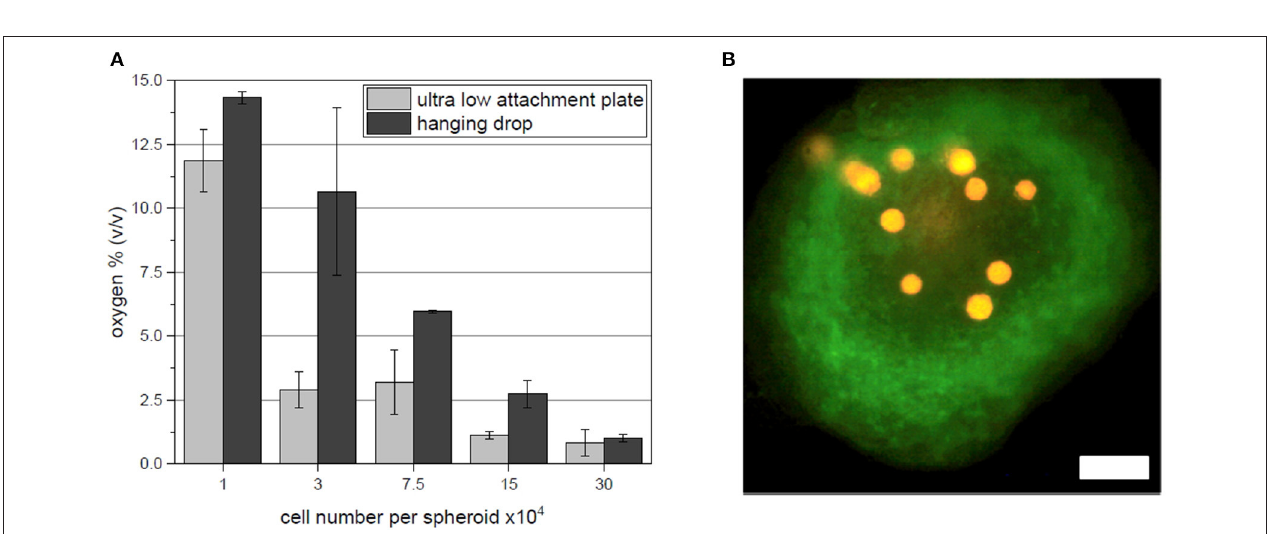
FIGURE 4 | (A) In situ oxygen measurements for each spheroids size and fabrication platform. (B) Exemplary fluorescent image of microbeads (orange) incorporated in a spheroid of 7.5 × 10 4 hypoxia reporter hAD-MSC (green) fabricated in ultra low attachment plates. Scale bar: 200 µ m.